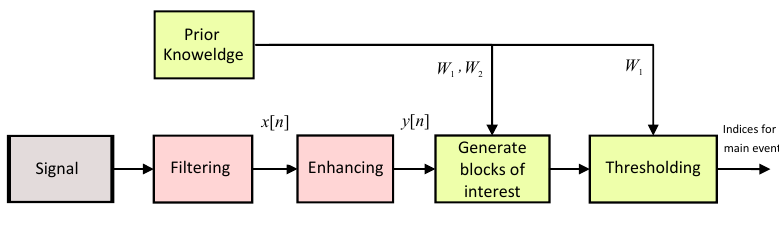
Figure 2. Flowchart of the two event-related moving averages (TERMA) algorithm for detecting the main event in a quasi-periodic signal. The algorithm consists of six LEGO building bricks: signal, filtering, enhancing, generating blocks of interest, thresholding and prior knowledge.